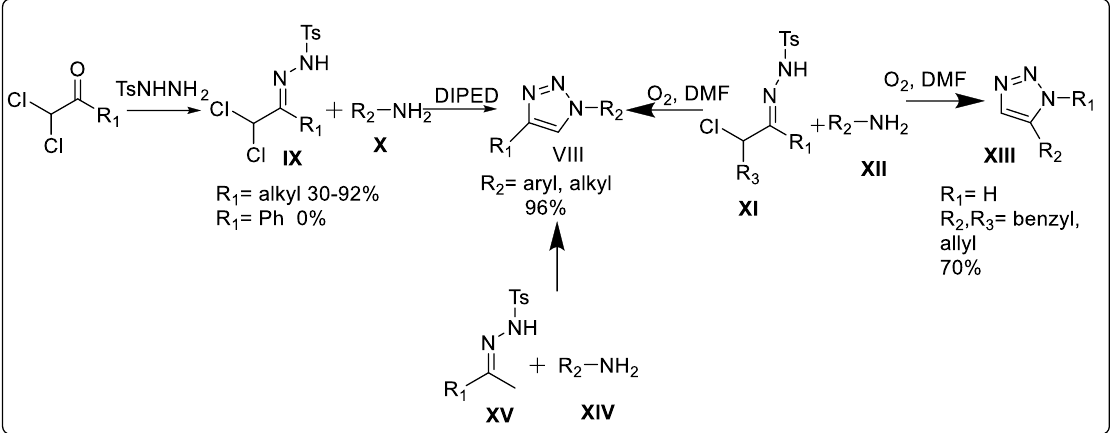
Figure 6. Metal-free methods of synthesizing